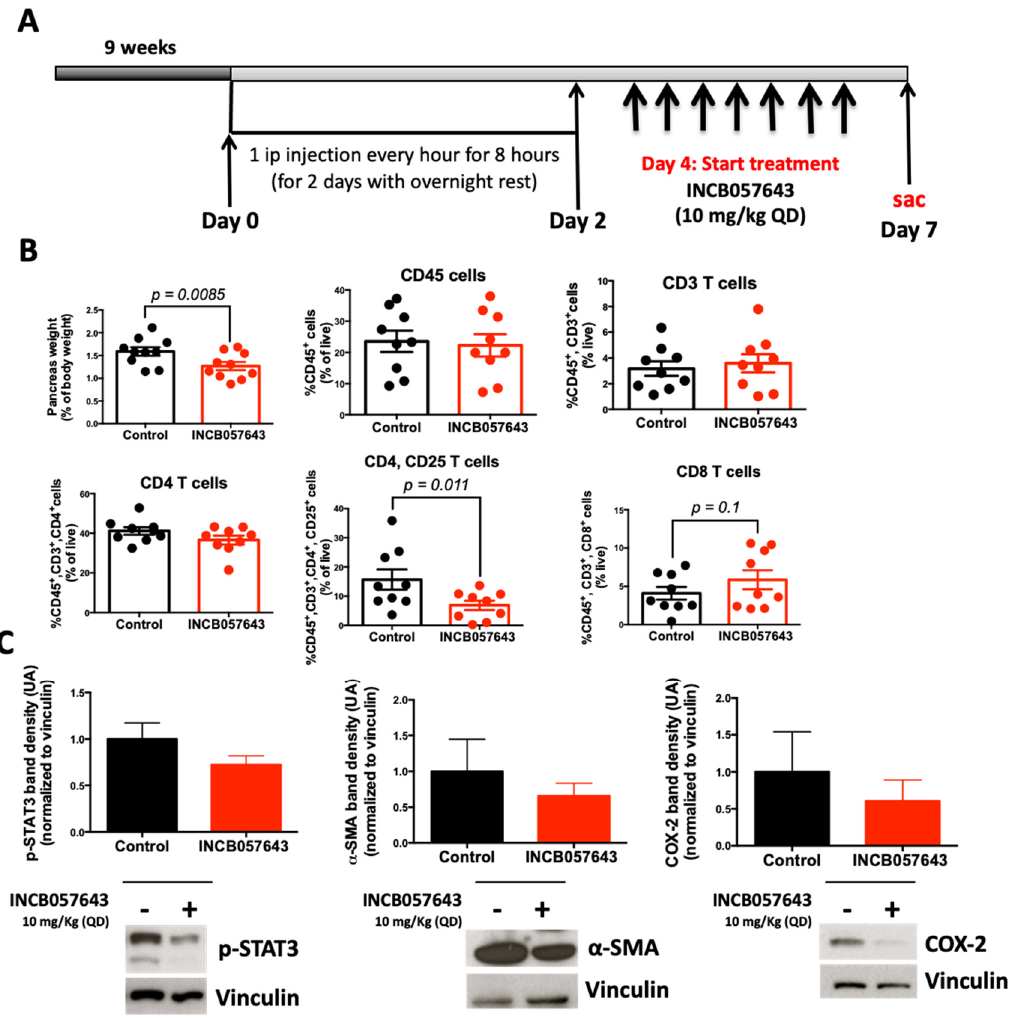
Figure 4. INCB057643 changes the inflammatory microenvironment in the pancreas of KC mice. LSL-Kras G12D/+ ; Pdx-1-Cre (KC) mice were treated with INCB057643 7 times a week, for 1 week, starting at 9 weeks of age. Blood, pancreas, and spleen were collected. ( A ) Experimental design, n = 9-10 mice/cohort. ( B ) CD45 + immune cells, CD45 + , CD3 + (CD3 T cells), CD45 + , CD3 + , CD4 + (CD4 T cells), CD45 + , CD3 + , CD4 + , CD25 + (activated CD4 T cells), and CD45 + , CD3 + , CD8 + (CD8 T cells) were analyzed by flow cytometry in the pancreas. ( C ) Levels of COX2, p-STAT3 and α -SMA in pancreas extracts were determined by western blot. For quantitation of the blots, INCB057643-treated samples were normalized to controls. Graph bar represents 6-10 mice/group. Uncropped Western Blot Images are shown in Figure S9.